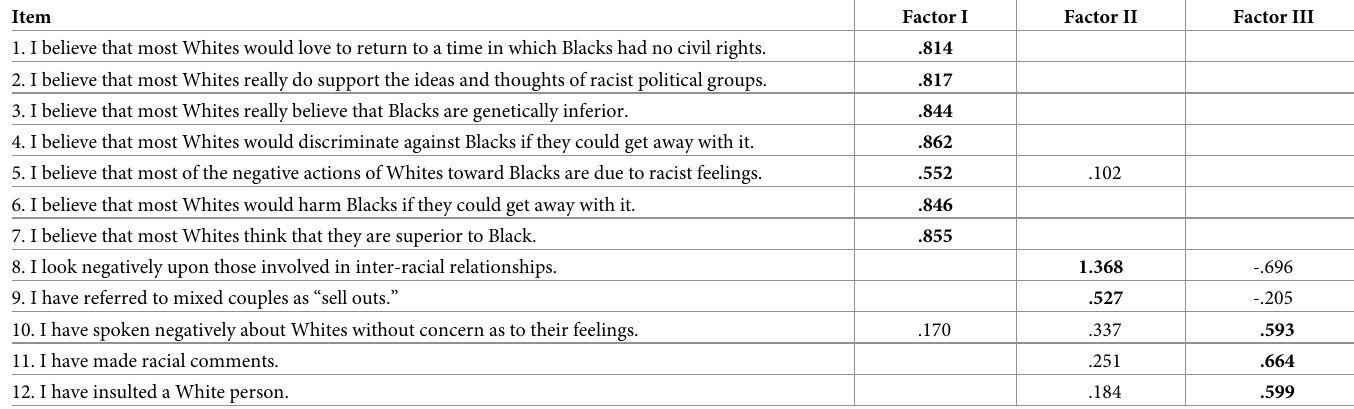
Table 2. Summary of ESEM results (standardized factor loadings and item content) for retained items of anti-White bias (Study